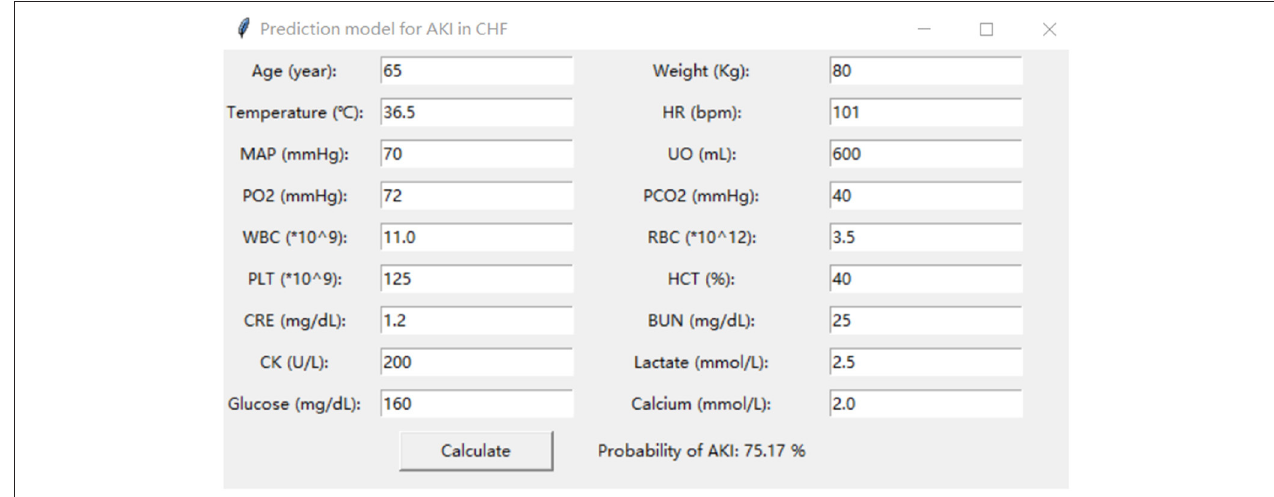
FIGURE 8 | An example of the prediction